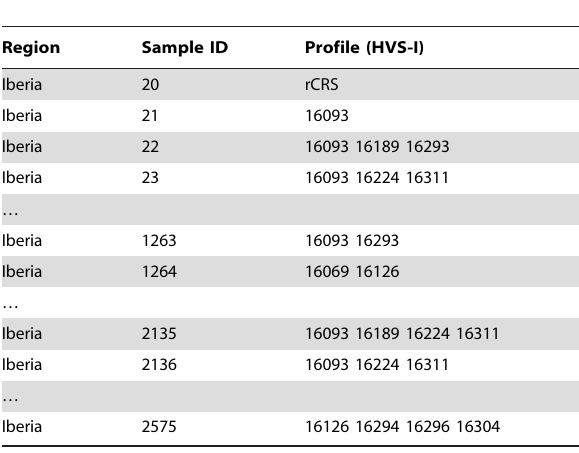
Table 1. Excerpts of the HVS-I mtDNA data; the sequence range is from position 16024 to position